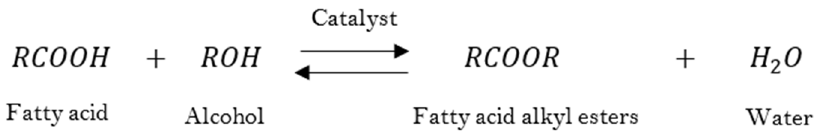
Figure 1. Esterification reaction of free fatty acids.